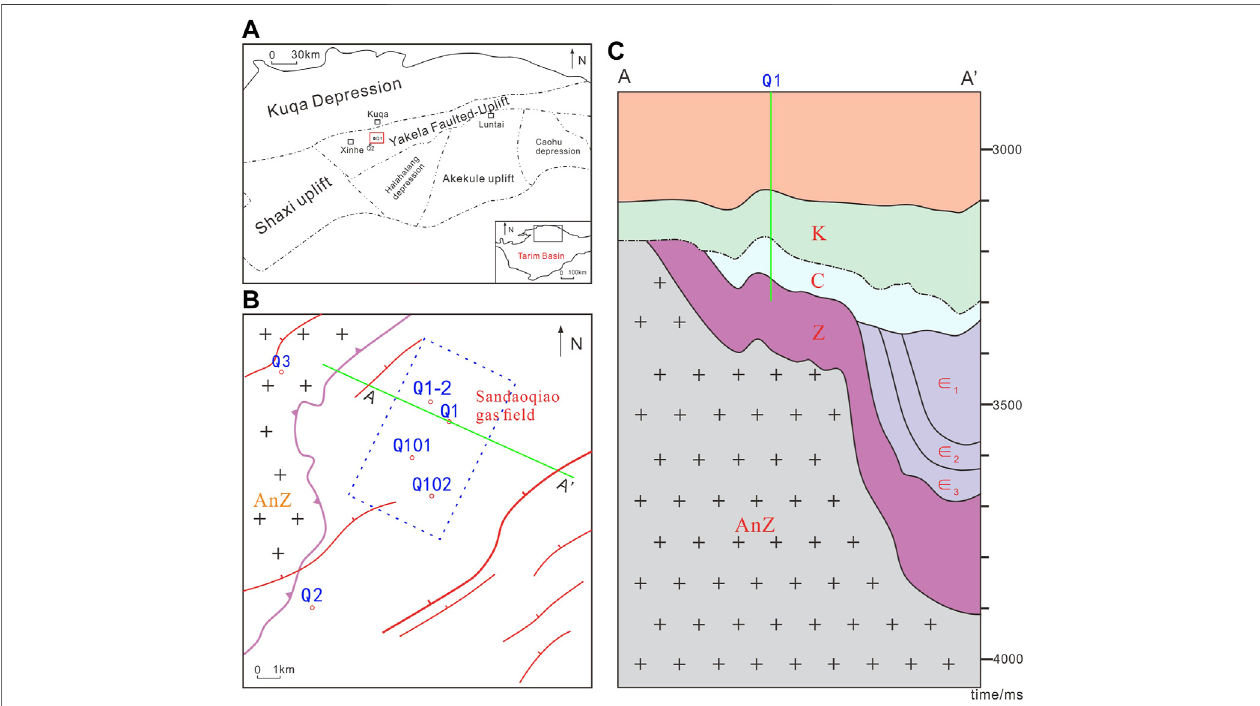
FIGURE 1 | (A) Structural location of sandaoqiao gas fi eld. (B) Stratigraphic elements and well location distribution map of the Cretaceous bottom boundary. The red lineisthemainfault,and thepurplelineistheSinianpinch-outline. (C) NW-SEdirectionsectionAA ’ stratigraphicstructure diagram.Thegreenlineisthetrajectoryof key well